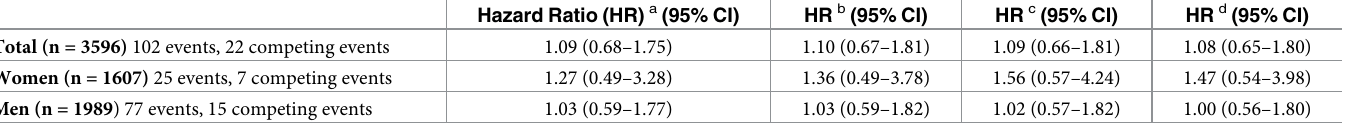
a Model 1: sex (excluded from stratified models), age, SES, working hours per week. b Model 2:sex (excluded from stratified models), age, SES, working hours, management, night shift. c Model 3: sex (excluded from stratified models), age, SES, working hours, management, night shift, living with partner, number of children under 18 years, time spent caring for children, time spent caring for relatives, time spent on household, time spent on hobbies/sport. d Model 4: sex (excluded from stratified models), age, SES, working hours, management, night shift, living with partner, number of children under 18 years, time spent caring for children, time spent caring for relatives, time spent on household, time spent on hobbies/sport, smoking, alcohol abuse, WHtR (per